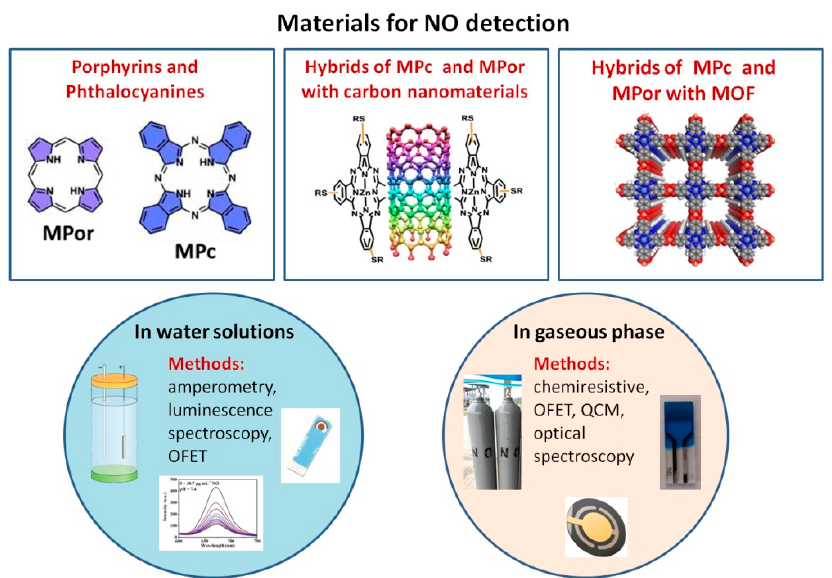
Figure 1. An overview of the main phthalocyanine- and porphyrins-based materials, which are used as active layers of chemical sensors for the detection of nitric oxide, discussed in this review.